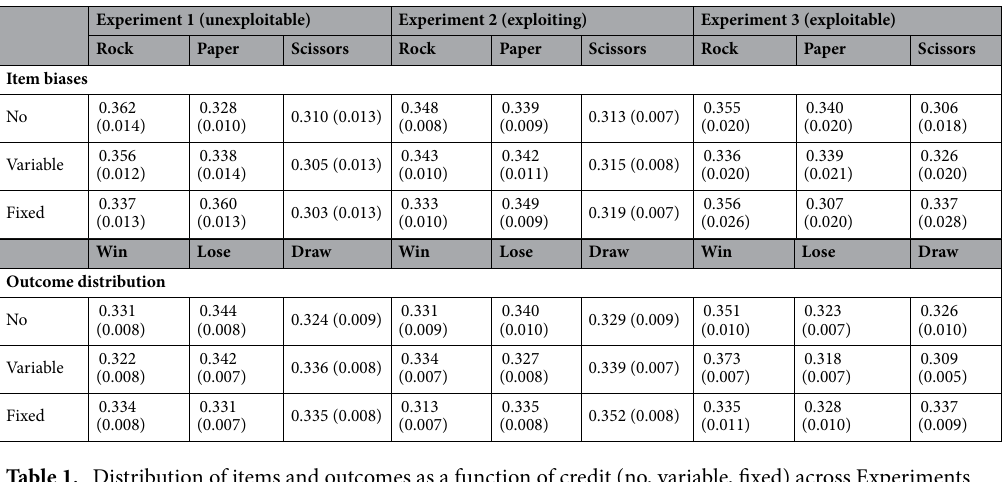
Table 1. Distribution of items and outcomes as a function of credit (no, variable, fixed) across Experiments 1–3. Standard error in